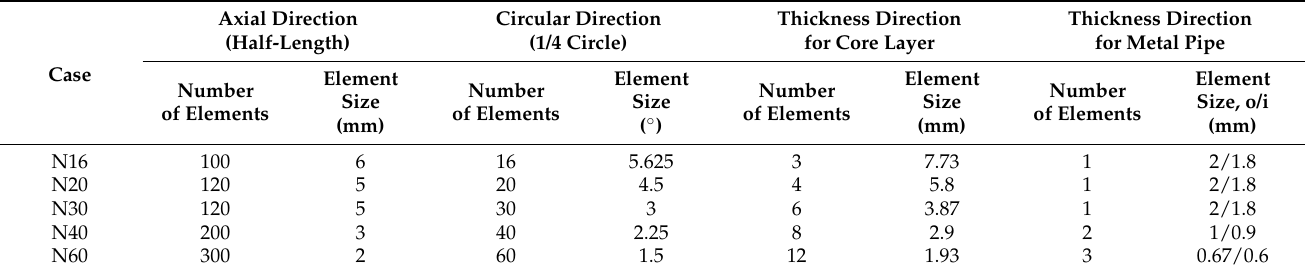
Table 3. Detail mesh division for N16~N60.